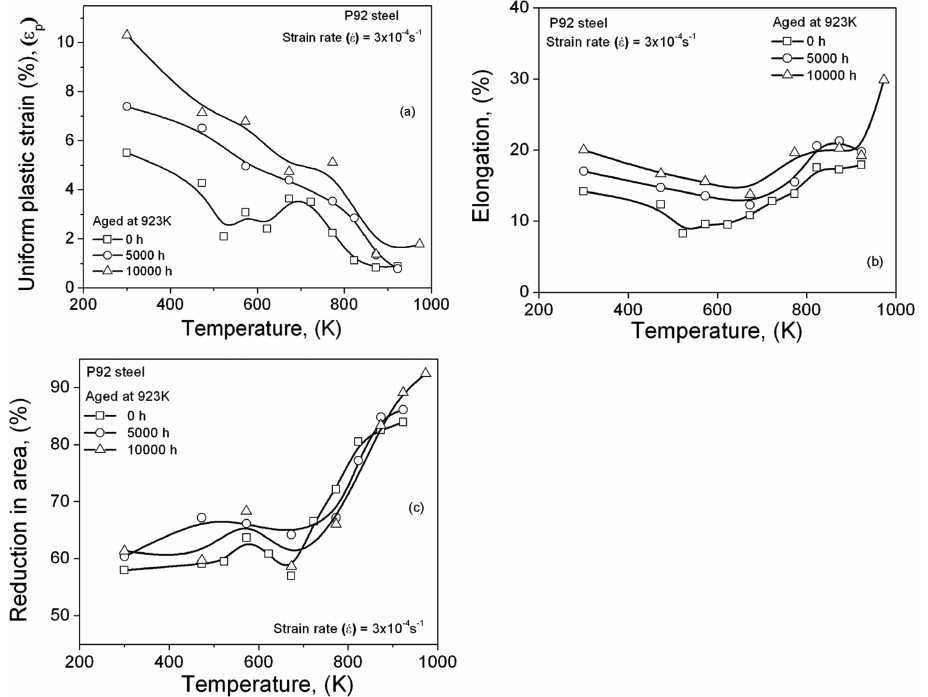
Figure 9: The variation of (a) uniform plastic strain, (b) elongation, and (c) reduction in area with test temperatures of P92 steel in the normalized and tempered, and thermal-aged